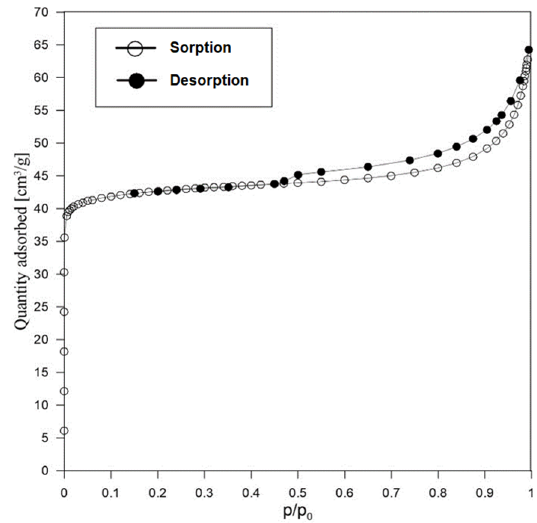
Figure 8. N 2 sorption/desorption isotherm in AS